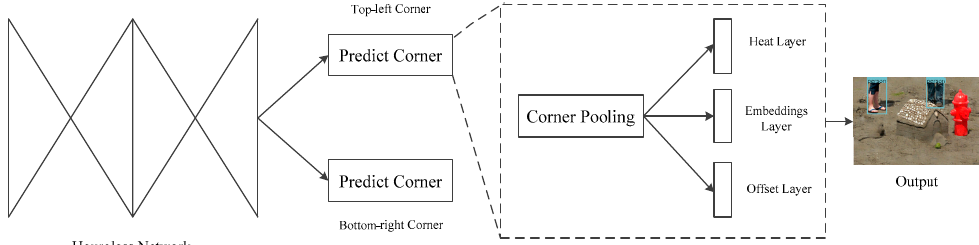
Figure 6. Architecture of pedestrian detection module.